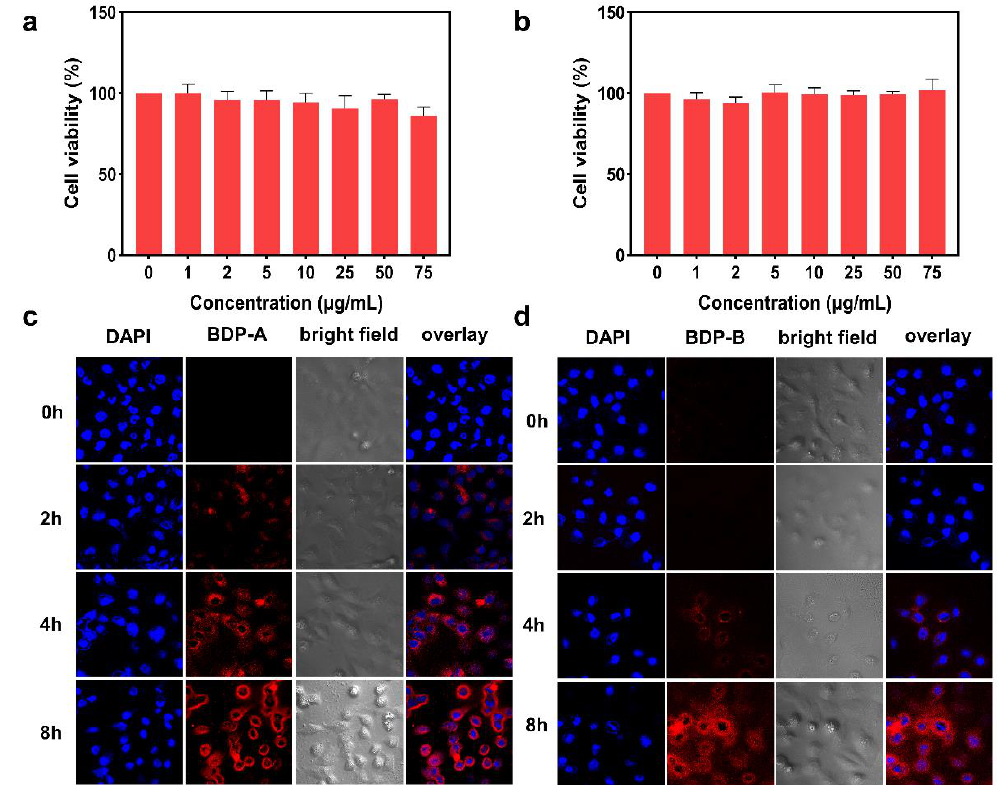
Figure 3. ( a ) Relative viabilities of HepG-2 cells after incubation with different concentrations of BDP-A NPs and ( b ) BDP-B NP solutions. ( c ) CLSM images of HepG-2 cells treated with BDP-A NPs and ( d ) BDP-B NPs (50 µ g/mL) in PBS (pH = 7.4) for various lengths of time; the nucleus was labeled with 2-(4-amidinophenyl)-6-indolecarbamidine (DAPI).